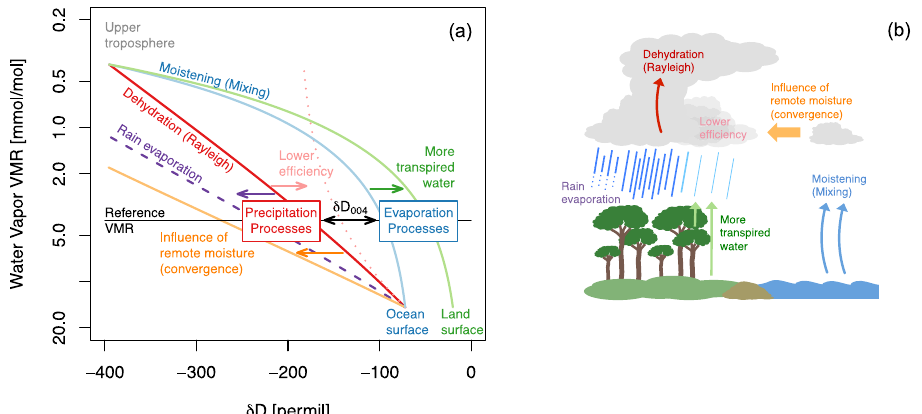
Fig. 1 The diagram of water vapor and δ D ( δ D _004) dynamics. a The processes in fl uencing δ D _004 variability, shown on a plot of water vapor volume mixing ratio ( y -axis) versus δ D ( x -axis). For a constant water vapor volume mixing ratio (4 mmol mol − 1 , fl at gray line labeled “ Reference VMR ” ), variations in the hydrogen isotope ratio ( δ D _004, shown in the Figure as δ D 004 ) represent the shifting importance of precipitation vs. evapotranspiration (ET-P). The precise scaling of δ D _004 to ET-P will be modi fi ed by the ef fi ciency of rainout (i.e., the ef fi ciency with which cloud condensate is converted to rain) and by the source of moisture to the atmosphere. For example, the two-sided black arrow shows the expected range of δ D _004 if oceanic evaporation is the sole source of moisture to the atmosphere (blue line) and condensate formed during convection is immediately removed from the atmosphere by precipitation (red line). The intersection of the blue and red lines with the “ Reference VMR ” line explicitly shows the expected δ D _004 values if P = 0 or ET = 0, respectively. As the contribution of transpiration to atmospheric moistening increases (green line), the δ D _004 range will extend to the right, causing the expected δ D _004 value to be higher when P = 0. Contrastingly, as either rain evaporation (purple dashed line) or remote moisture convergence (orange line) becomes important, the δ D _004 range will extend to lower isotope ratios, causing the expected δ D _004 value to be lower when ET = 0. Decreasing the ef fi ciency with which condensate forms precipitation (pink dotted line) will, in comparison, increase the expected δ D _004 value when ET = 0, limiting the expected δ D _004 range for a given set of ET-P states. b The schematic illustrates the key processes in ( a ).